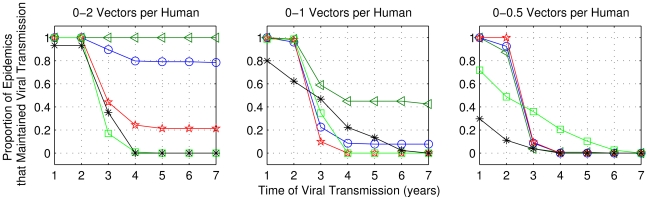
As in
Figure 15
, considering 1.5 bites per day.